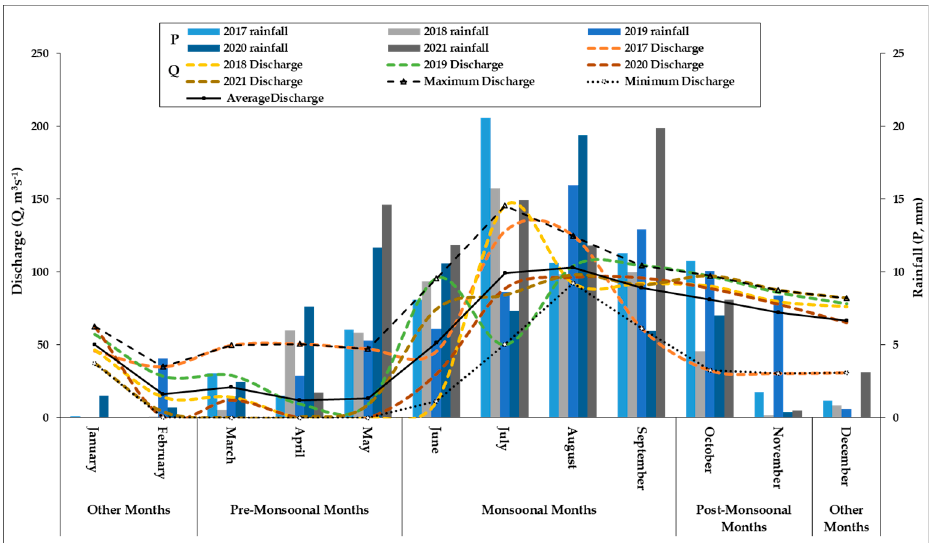
Figure 5. The simulated hydrographs of monthly discharges (lines) against the background of the observed monthly amount of rainfall (a bar chart) along with the minimum, maximum, and average discharge in 2017–2021 on the Delta Sub-Basin of Subarnarekha River Basin.